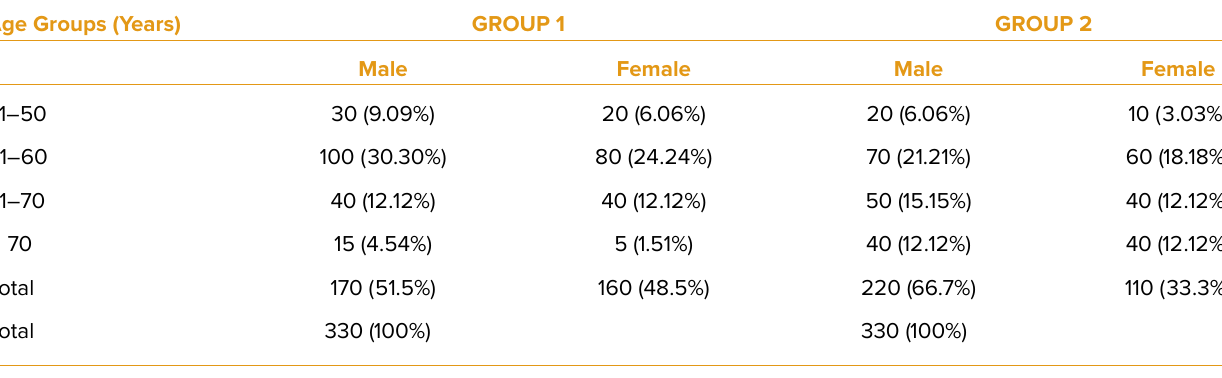
Table 1. Age- and sex-wise distribution of study subjects among the two study groups